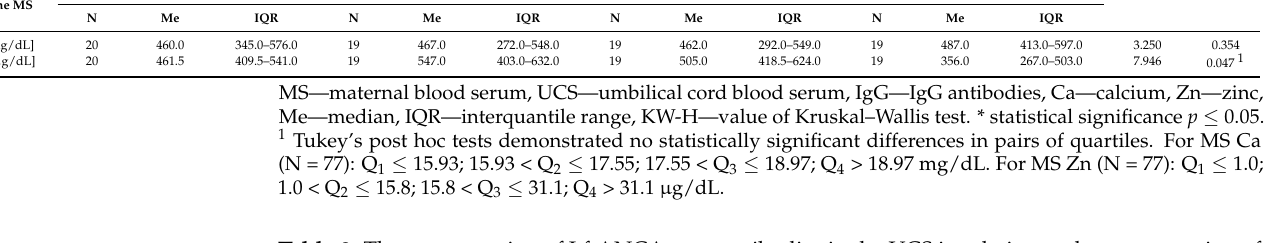
Table 8. The concentration of Lf-ANCA auto-antibodies in the UCS in relation to the concentration of Ca and Zn in the MS divided into